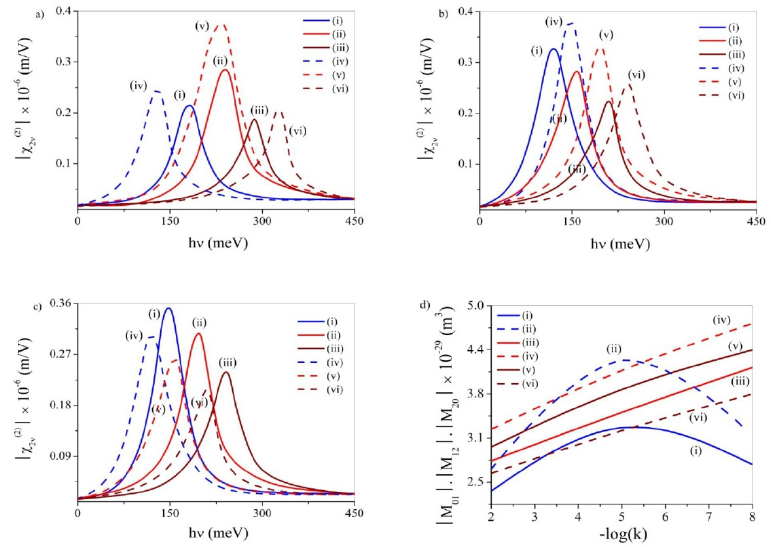
Figure 7. SHG vs. h υ diagrams ( a ) devoid of noise, ( b ) under ADWN and ( c ) under MLWN. In these diagrams the anharmonicity has (i) odd parity and k = 10 − 8 , (ii) odd parity and k = 10 − 5 , (iii) odd parity and k = 10 − 2 , (iv) even parity and k = 10 − 8 , (v) even parity and k = 10 − 5 , (vi) even parity and k = 10 − 2 . ( d ) Depiction of GF for SHG vs. − log(k): (i) devoid of noise and OPA, (ii) devoid of noise and EPA, (iii) with ADWN and OPA, (iv) with ADWN and EPA, (v) with MLWN and OPA and (vi) with MLWN and EPA. Under applied ADWN, both with OPA and EPA, the SHG peaks discern blue-shift and drop in the peak altitude with enhancement of k . Thus, with ADWN, the parity of the